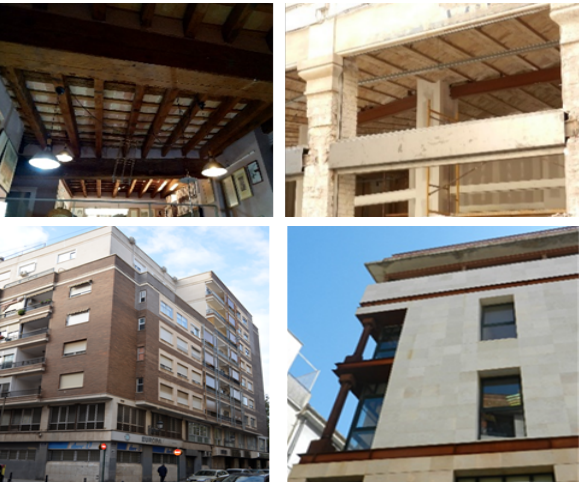
Figure 16. Example of structural typologies in Valencia: